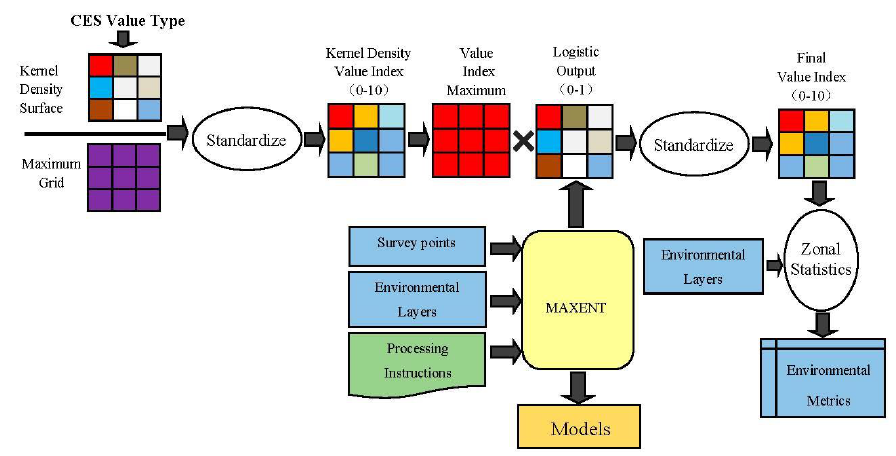
Figure 2. The value index (VI) maps generalized key process flow. Table 4. Key equations in SD Model.